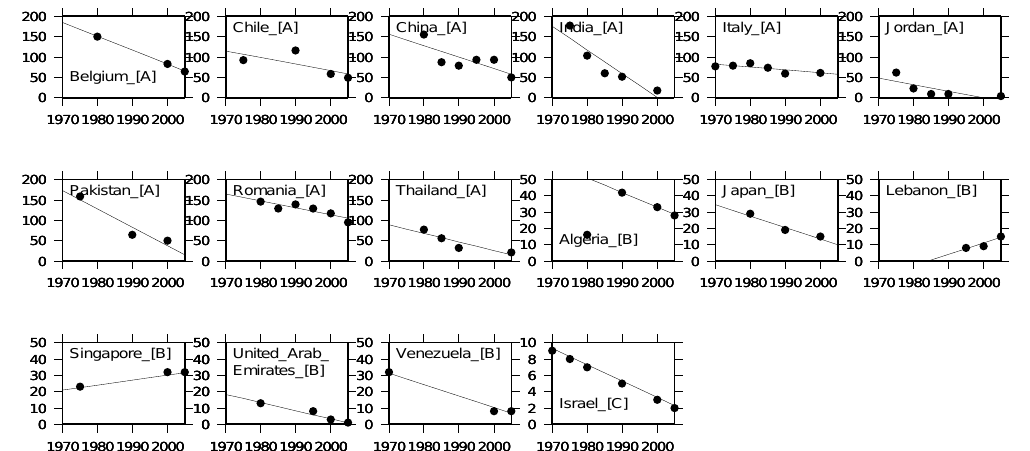
Fig. 4. Historical records of national industrial water intensity (plot) and regressions (line) (m 3 yr − 1 MWh − 1 ) .